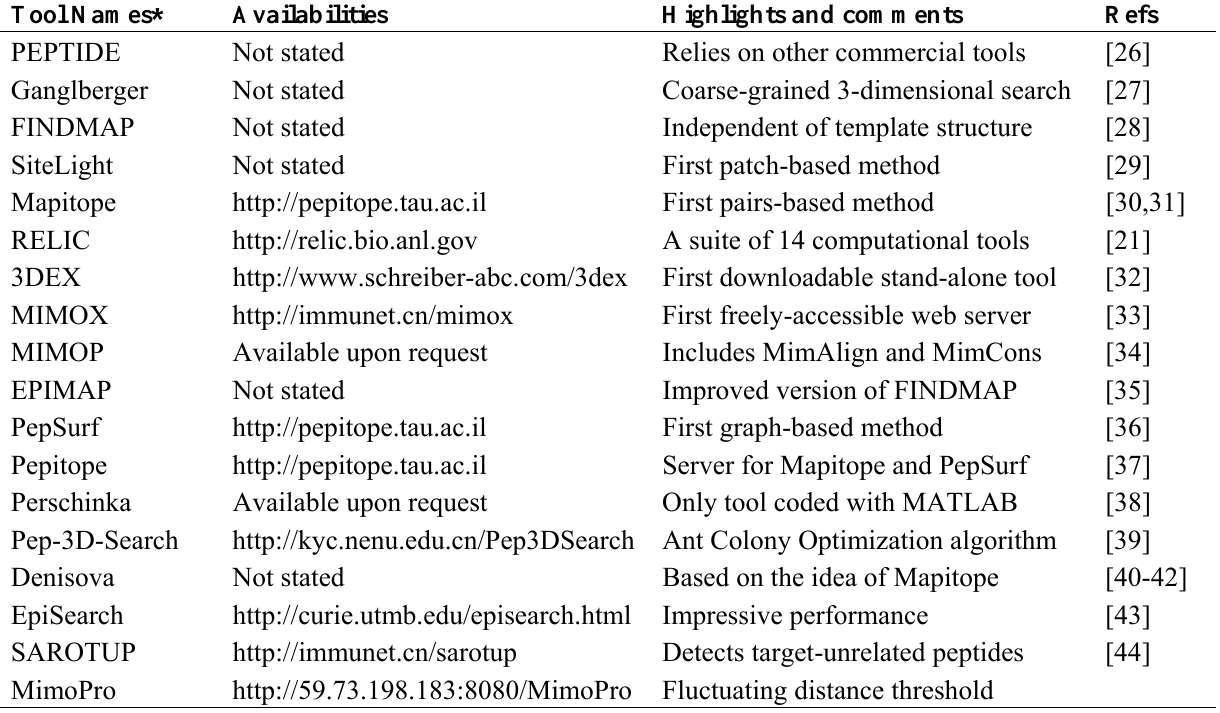
Table 2. Computational tools for mimotope